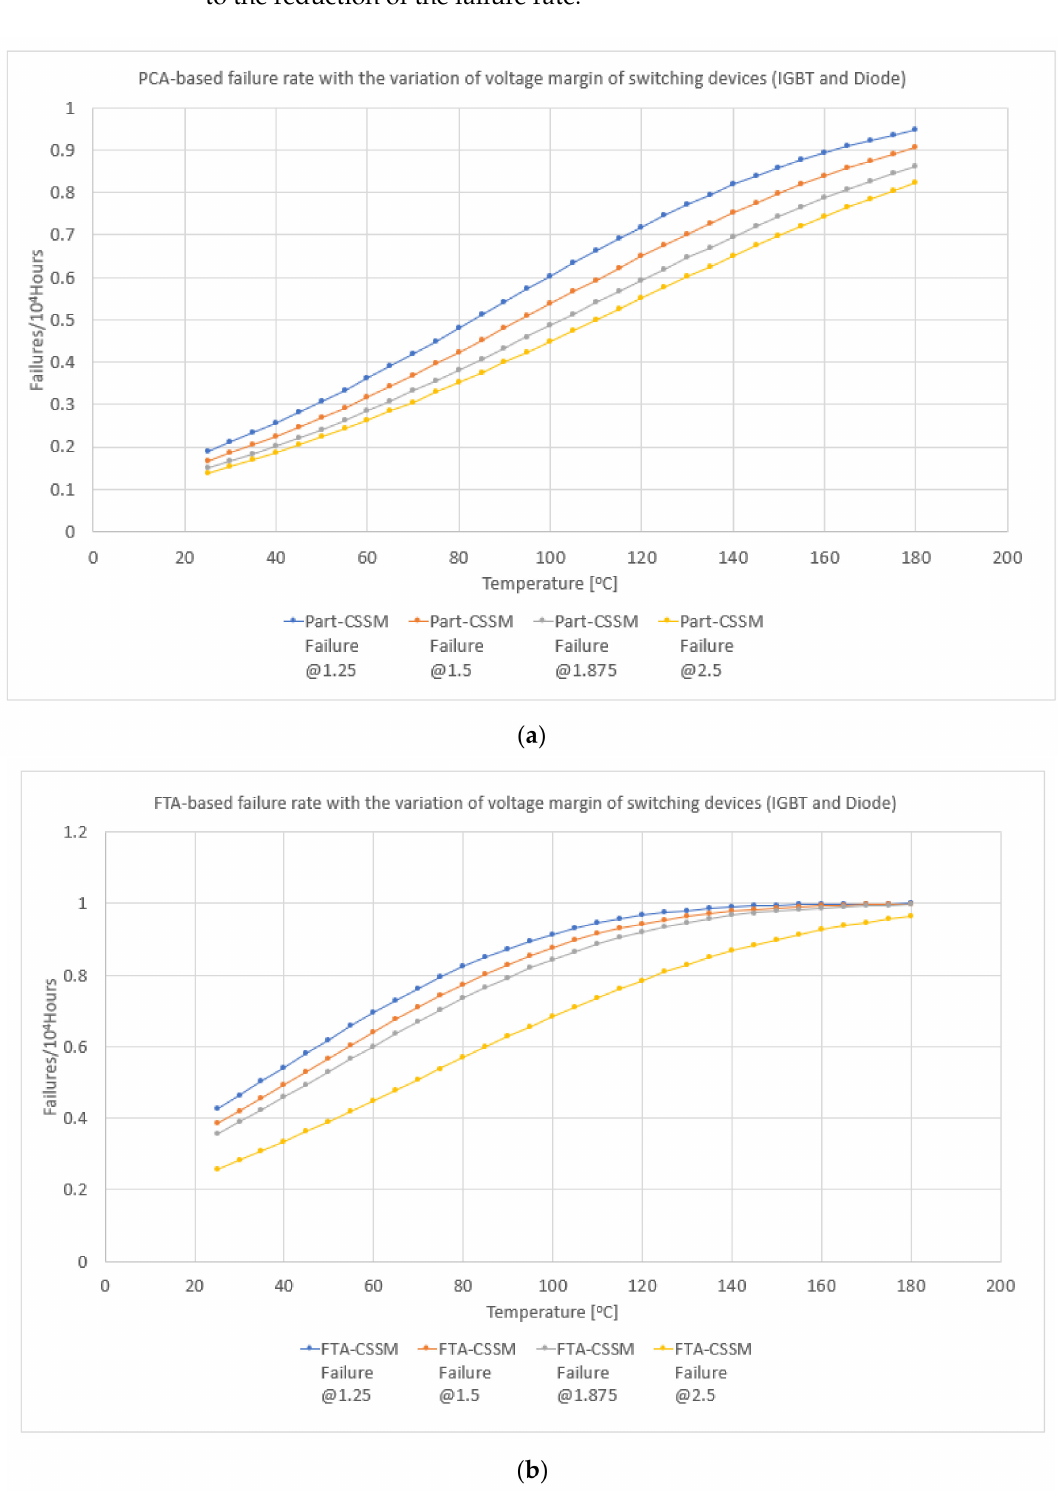
Figure 12. Failure rate according to voltage margin of switching devices in CSSM, ( a ) by PCA, ( b ) by